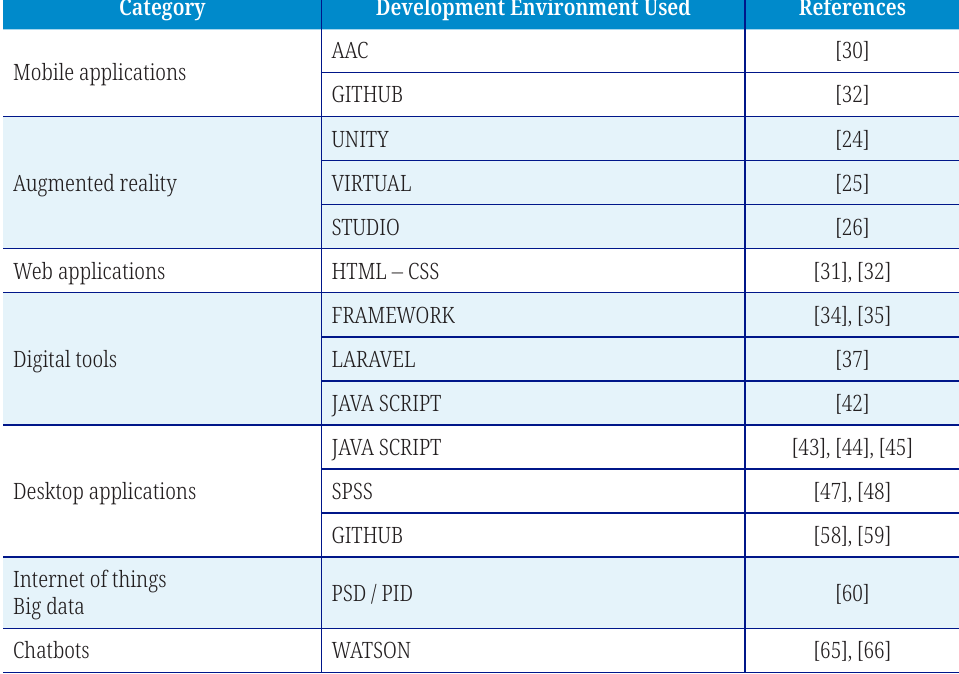
Table 6. Classification of articles according to development environment